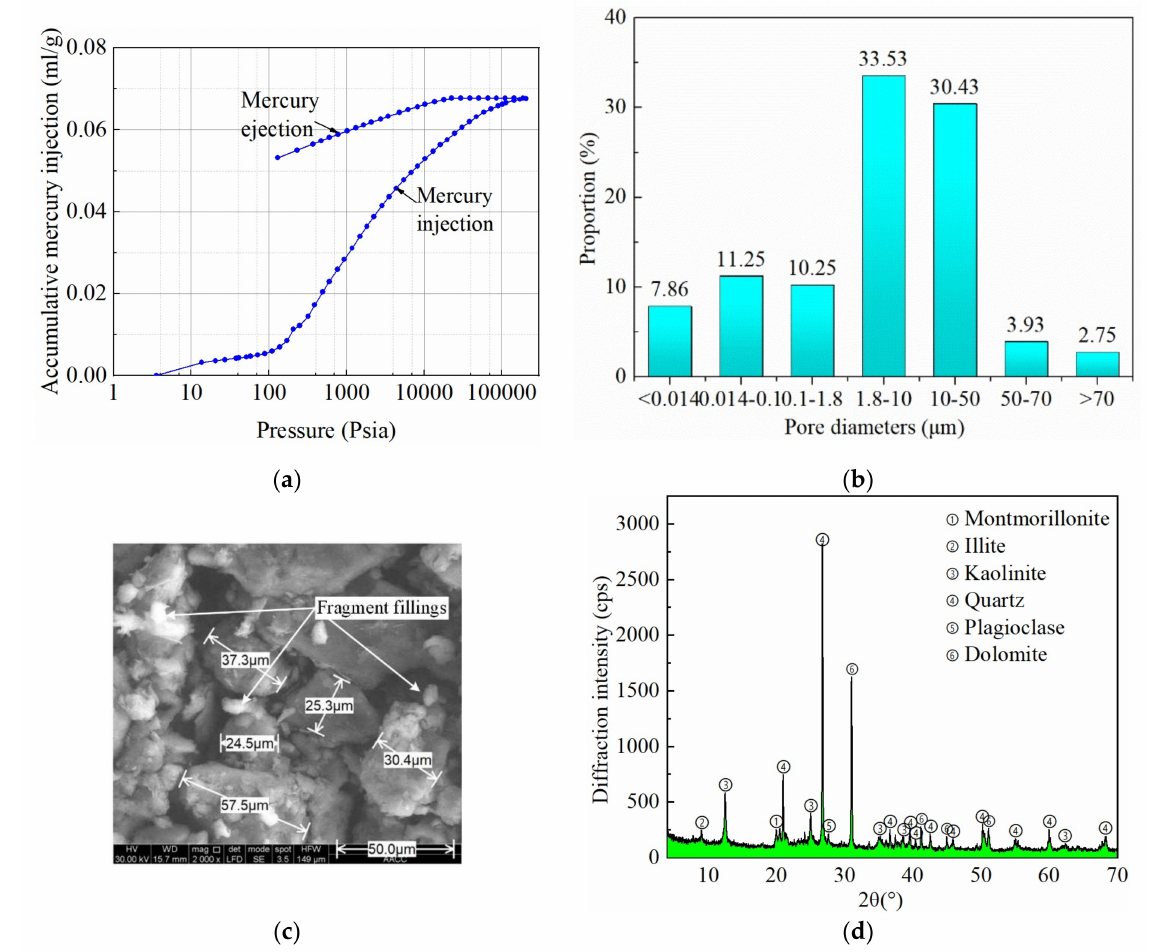
Figure 2. Physical properties of weakly cemented rocks: ( a ) mercury injection–ejection curves; ( b ) pore diameter distribution; ( c ) microscopic structures of pores and minerals via SEM imaging; ( d ) mineral composition via XRD